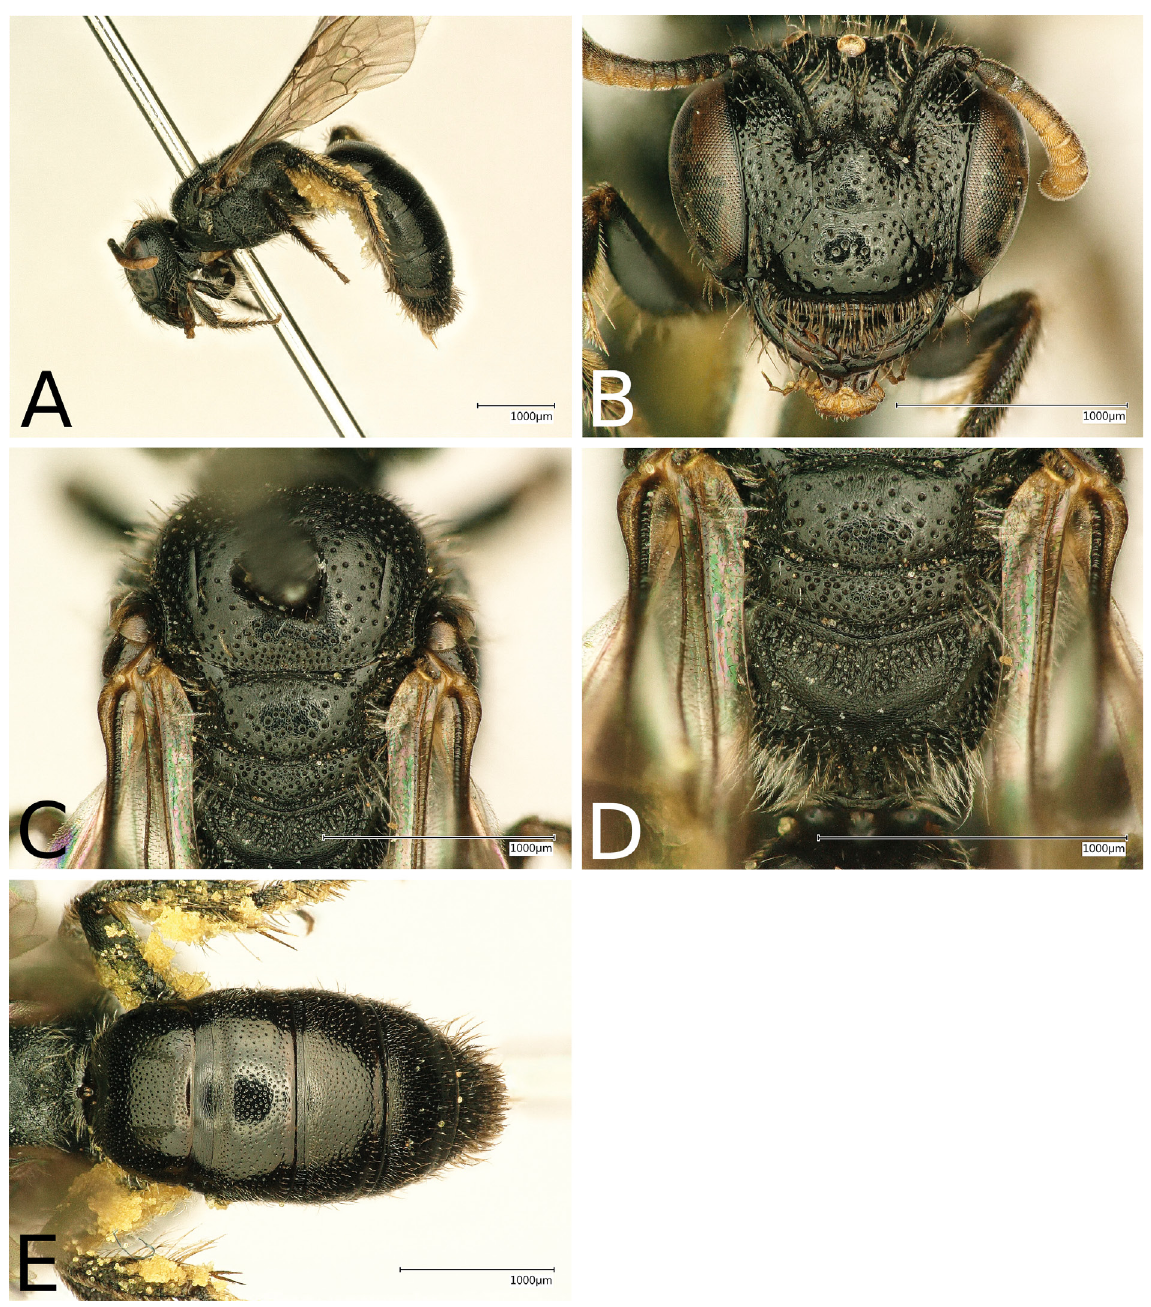
Fig. 9. Scrapter oubergensis Kuhlmann sp. nov., ♀, holotype (RCMK). A . Lateral view. B . Head. C . Scutum and scutellum (dorsal view). D . Metanotum and propodeum (dorsal view). E . Metasoma (dorsal